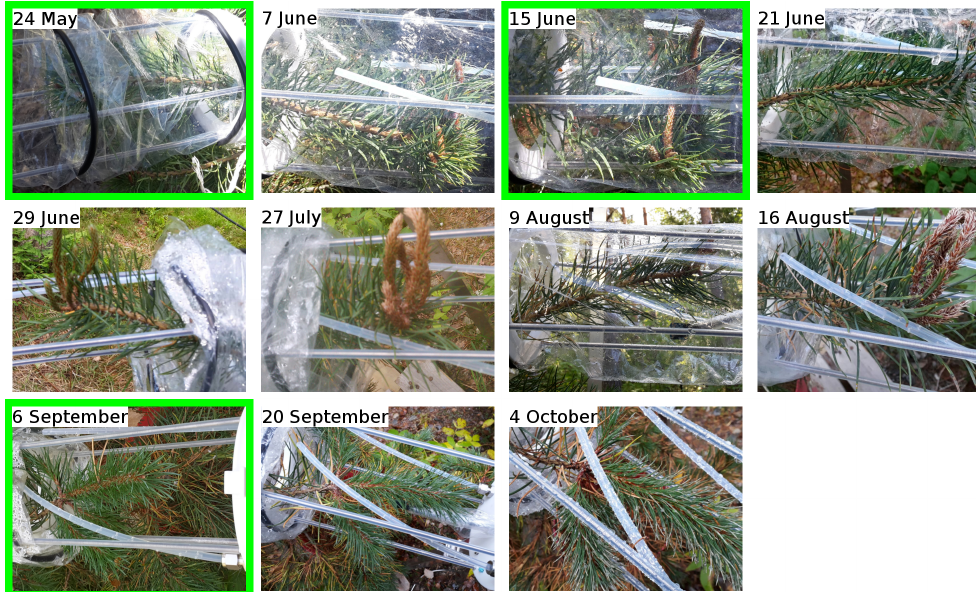
Figure A1. Pictures of pine branches. Dates framed in green indicate that a new branch was placed in the enclosure.